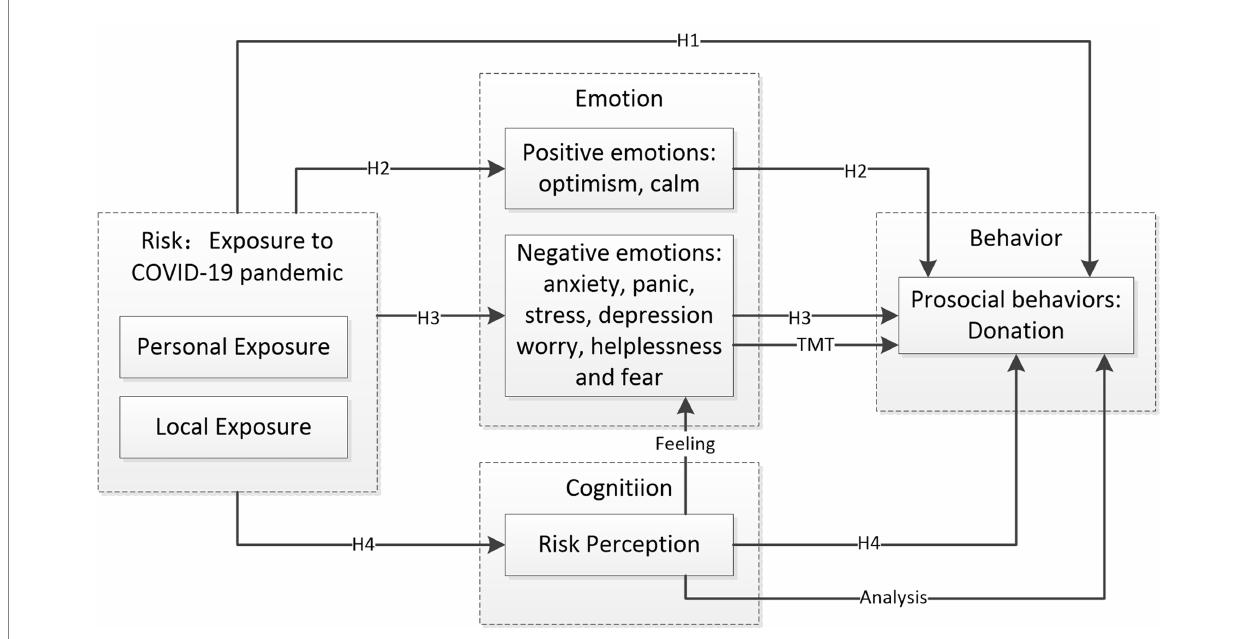
FIGURE 1 A psychological framework and hypotheses of donation behaviors in the context of COVID-19